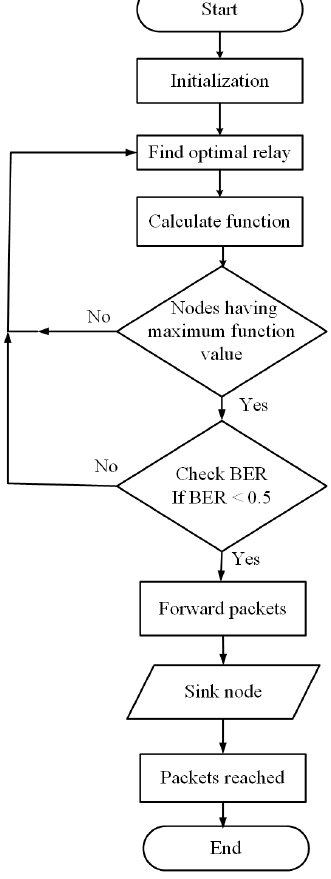
Figure 5. Flow chart of EERD